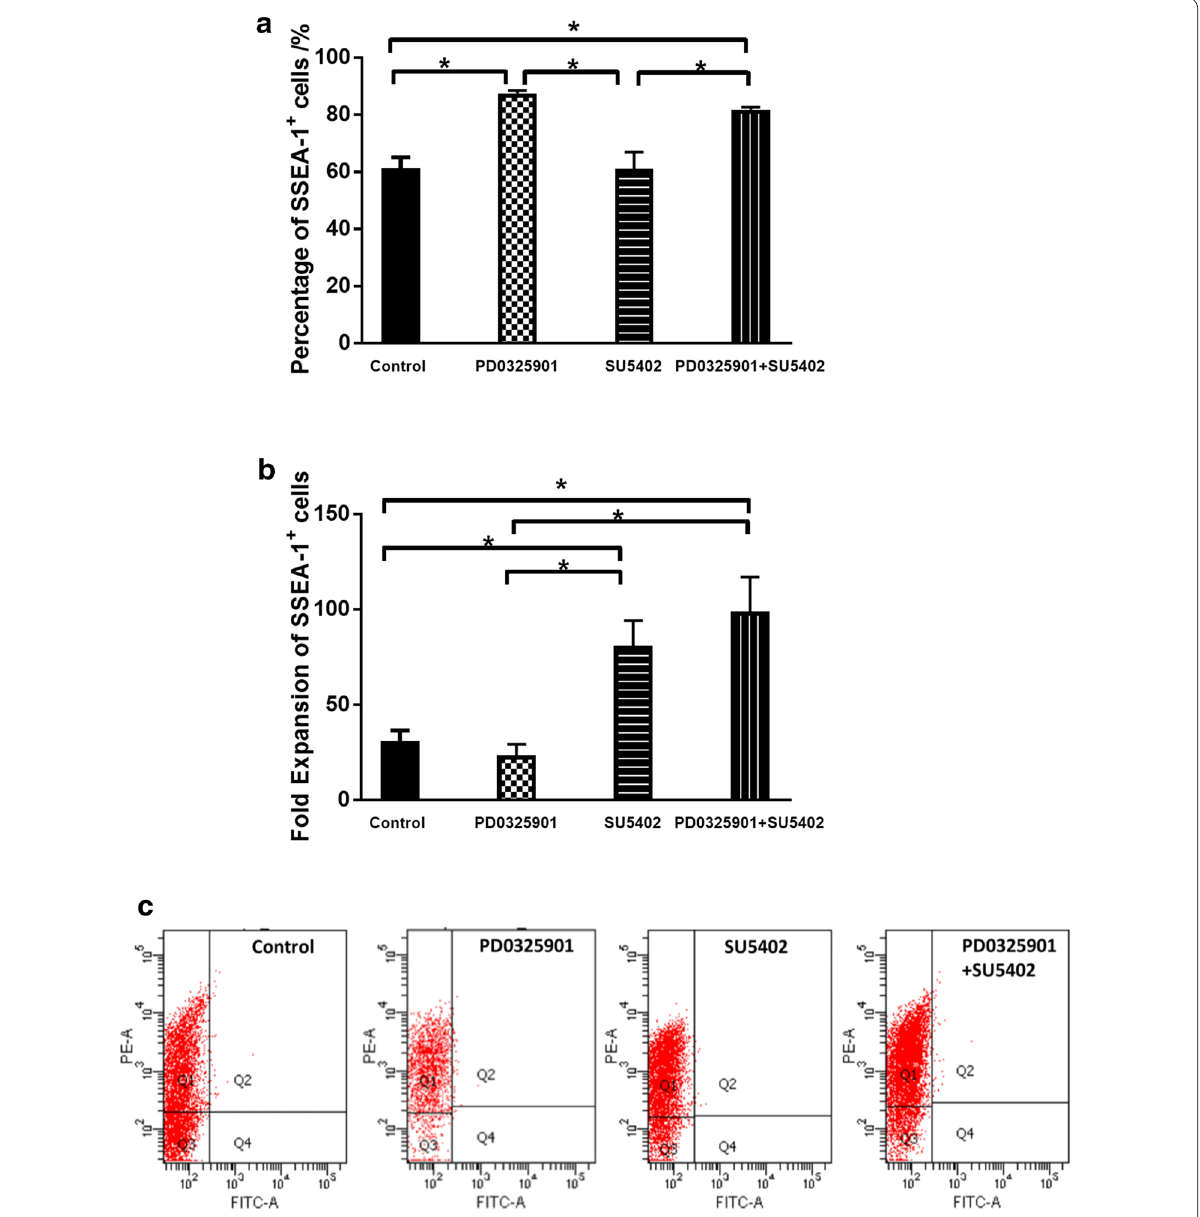
Fig. 2 Effect of FGFR inhibitors and MEK inhibitors on mESC pluripotency. Cells were cultured with 1 uM PD0325901, 2 uM SU5402 or their combination. a The percentage of SSEA‑1 + cells after 3 passages. b Fold expansion of SSEA‑1 + cells after three passages. c Signal threshold for SSEA‑1 + cell in flow cytometry. Error bars are standard deviations ( n 3). *Represents significant difference ( P < =